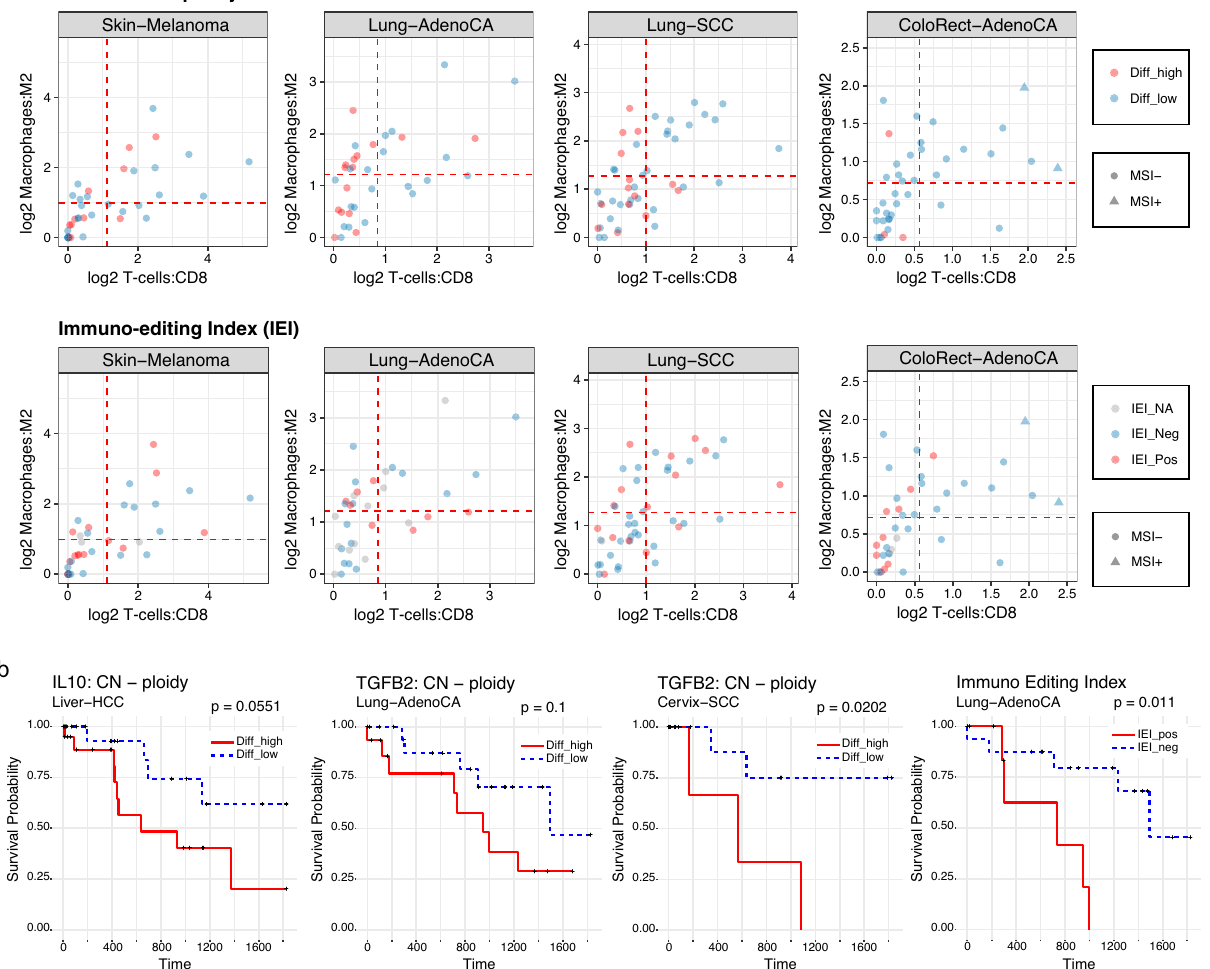
Figure 3. Associations among genomic alterations, immunoediting history, activities of infiltrated immune cells, and clinical outcome. ( a ) Flow cytometry-like plots representing the estimated activity of infiltrated CD8 + T-cells ( x -axis) and M2 macrophages ( y -axis). The dotted red line and circle represent the mean value for each axis and a sample, respectively. ( b ) Kaplan–Meier curves for overall survival were drawn using the information of selected copy number gains of IL10 and TGFB2 and the scores of IEI. If the score of selective copy number gain of a gene, which is defined by the difference between the copy number of the gene and the ploidy of the sample, was greater than or equal to one, the sample was classified into the Diff_high group. For the scores of IEI, the cut-off value was set as 0 for determining the IEI_Pos and IEI_Neg groups. P-values were obtained using log-rank